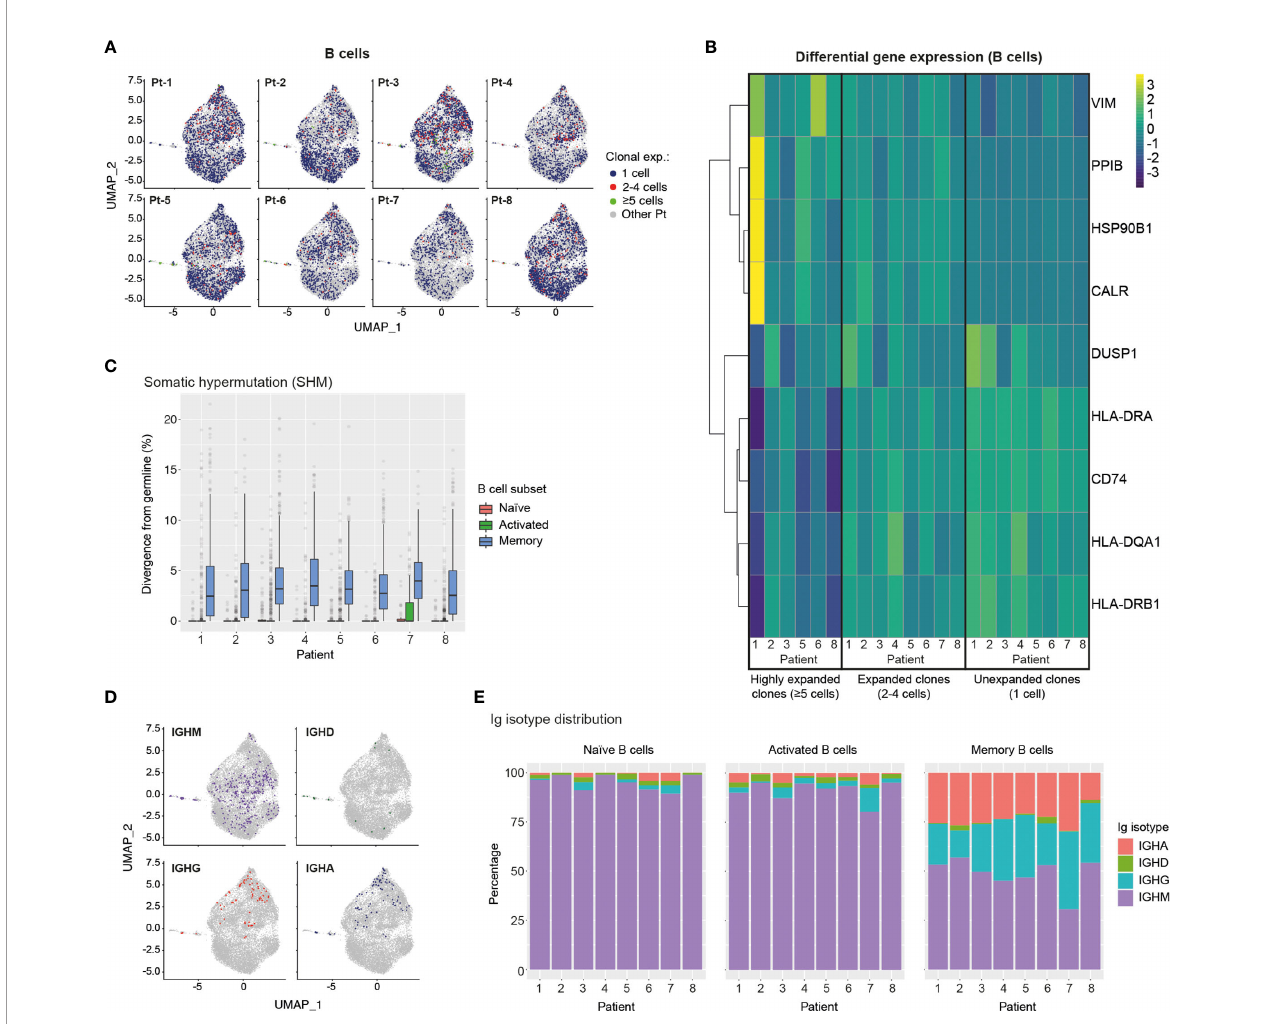
FIGURE 5 | Single-cell transcriptome and BCR pro fi ling reveals elevated class-switching and somatic hypermutation levels in memory B cells. (A) UMAP plots display B cells from speci fi c patients according to their clonal expansion levels. B cells from other patients in each individual plot are shown in grey. (B) Heatmap shows differential gene expression (DGE) in unexpanded, expanded and highly expanded B cells. Genes were fi ltered to include those with detectable expression in at least 50% of cells and that had a minimum 50% fold-change in expression level between groups. (C) Graph displays the levels of somatic hypermutation (SHM) in the BCRs of naïve, activated and memory B cells across patients. SHM levels are based on the percentage similarity between BCR heavy chain V-gene and its corresponding germline. Data are displayed as median ± IQR. (D) Graph shows the distribution of B cells expressing speci fi c Ig isotypes relative to their location in transcriptome UMAP plots. B cells from all patients are shown. (E) Bar graphs show Ig isotype distribution of BCRs found in naïve, activated and memory B cells across patients. CALR, Calreticulin; CD74, HLA class II Histocompatibility Antigen Gamma Chain; DUSP1, Dual Speci fi city Phosphatase 1; HLA-D,